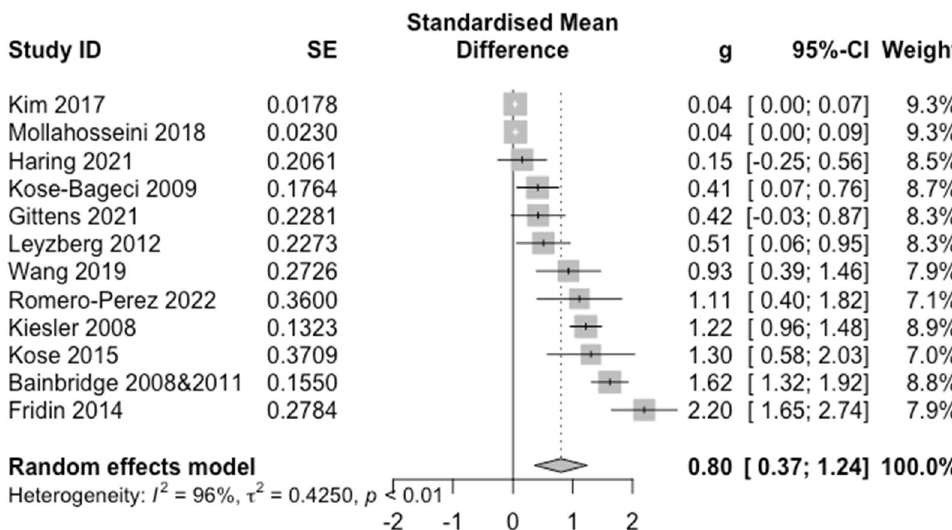
Figure 6. Forest Plot of EF. For each study and the average effect size, the plots show standardised mean differences (hedges’ g), standard error (SE), the 95% confidence interval (95% CI), and the weight in the random effect model. Heterogeneity is represented by the between study Higgins & Thompson’s 𝐼 (cid:2870) , heterogeneity variance 𝜏 (cid:2870) and p -value.